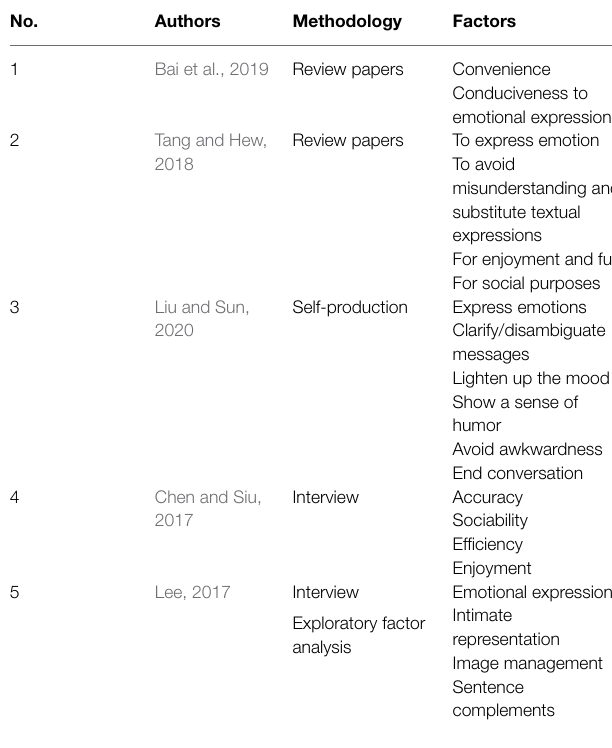
TABLE 1 | Previous studies on the motivation for using emojis and